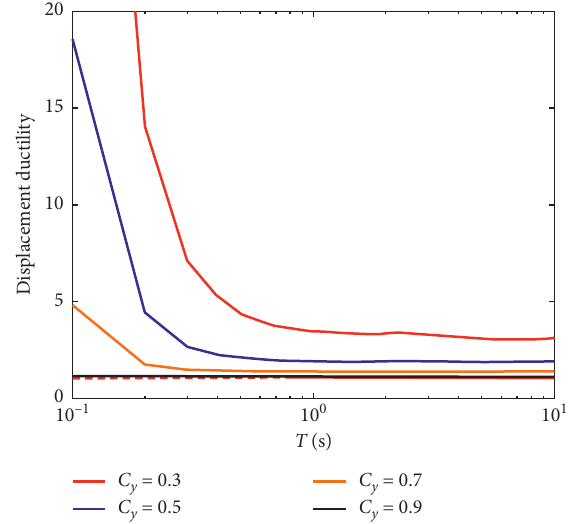
Figure 5: Effect of different yield strength coefficients ( C 0.7, and 0.9) on the variation of the mean constant-strength ductility spectra.